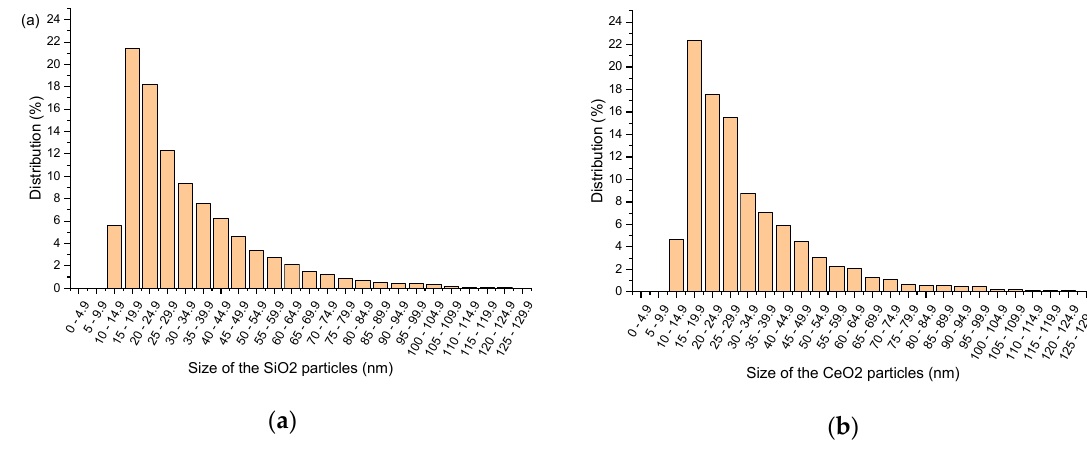
Figure 2. Size distribution of ( a ) SiO 2 nanoparticles ( b ) CeO 2 nanoparticles.